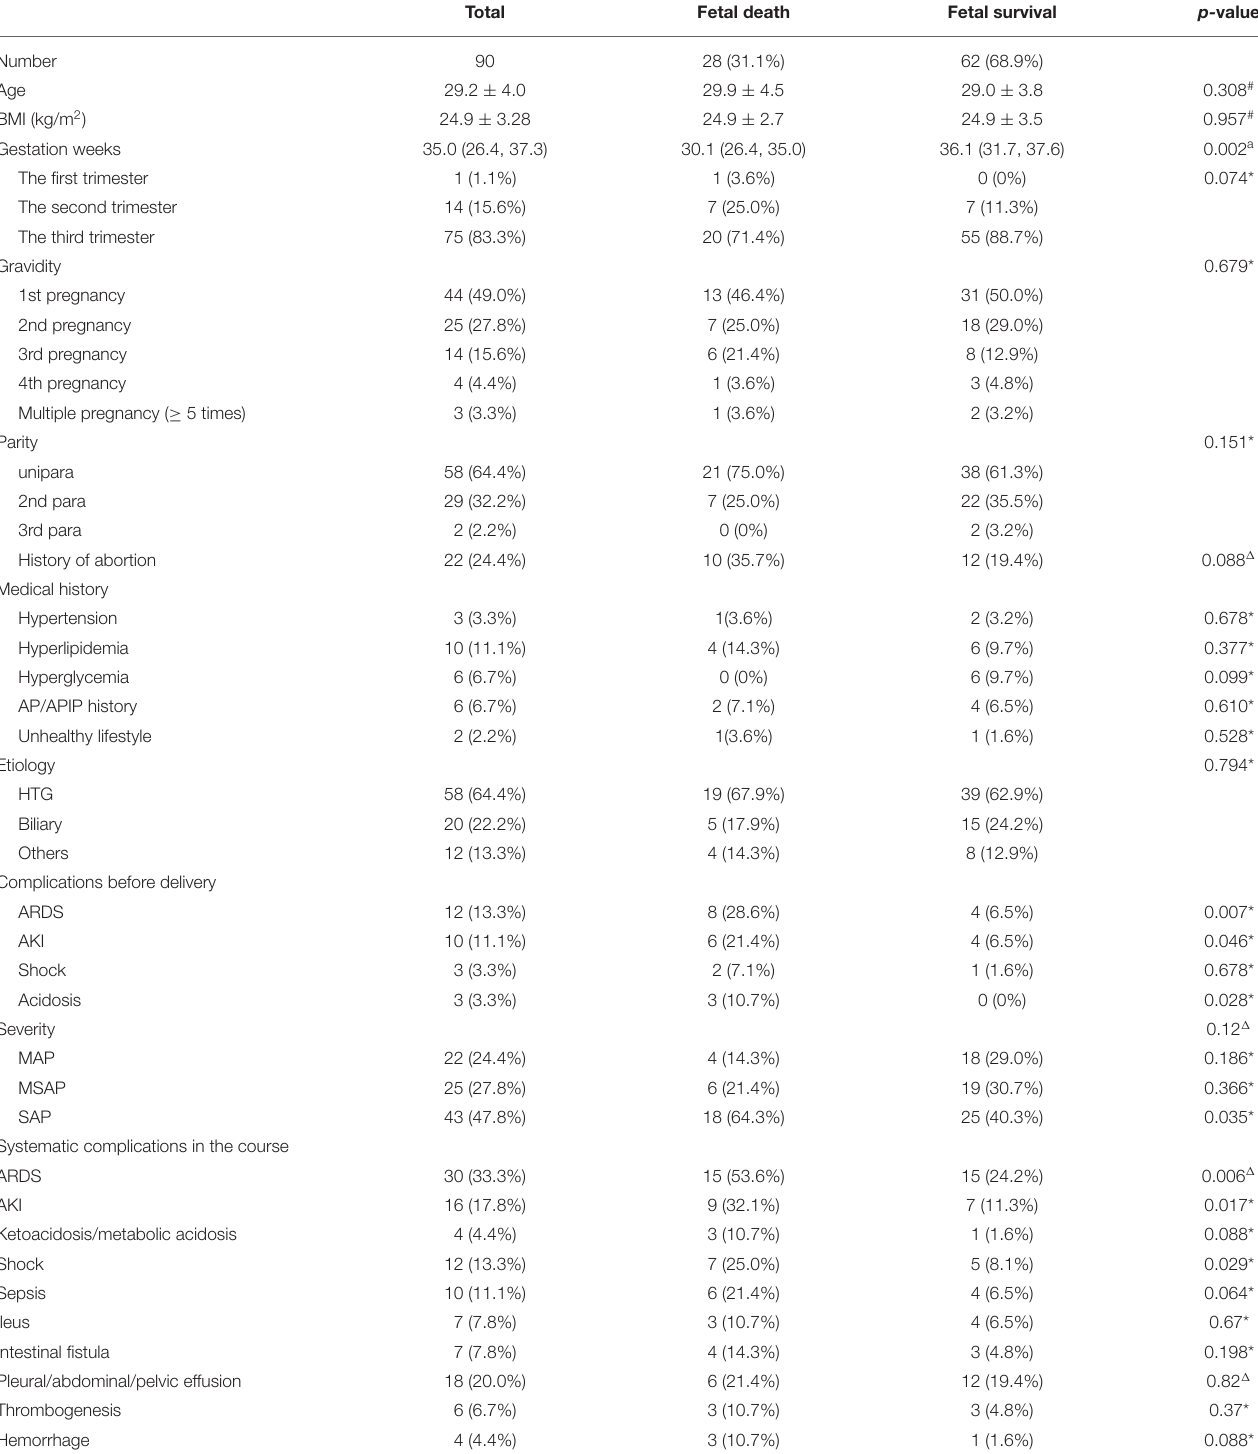
TABLE 1 | Characteristics between the fetal death and fetal survival